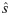
Quantifying the decrease in uncertainty from increased sequencing.Histograms show distributions of overlap estimates s^, computed using Eq (11), for various values of s which are indicated by color-matched dotted lines. While all estimates are distributed around the true values of s, increasing the number of colonies c from 48 (top) to 96 (middle) and to 144 (bottom) substantially decreases the error of estimates. For example the bottom plot shows that successfully sequencing c = 144 colonies from each parasite is guaranteed to produce estimates s^ that are off by at most 5 (8.3%) in either direction of the true s.